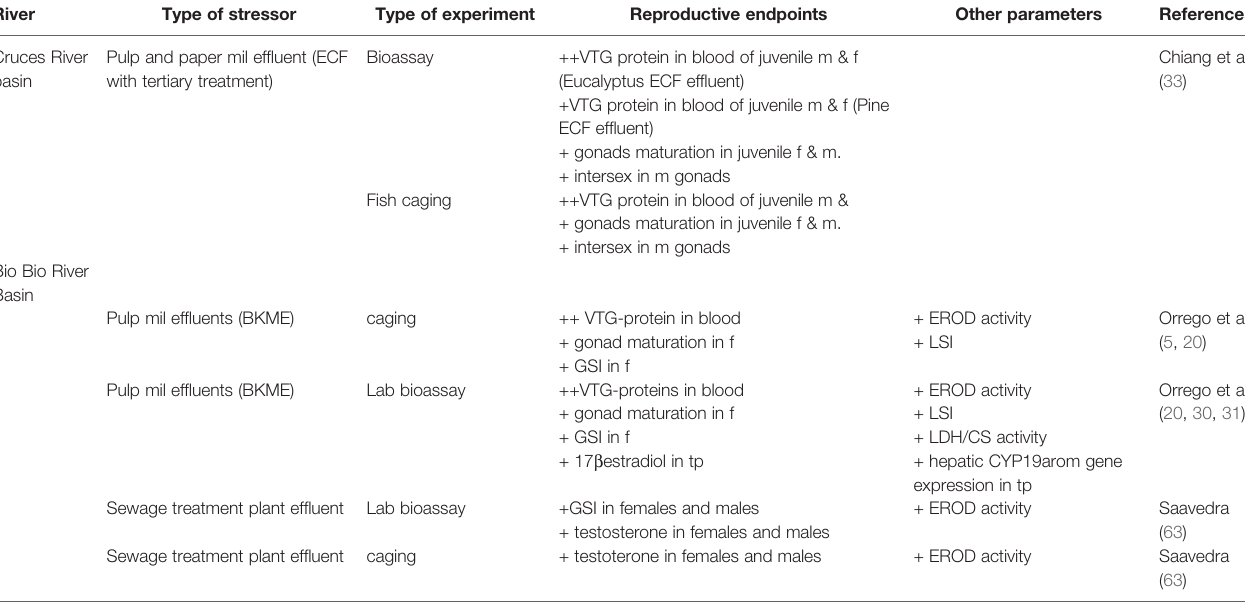
TABLE 1 | Most relevant biological responses to EDCs in rainbow trout at